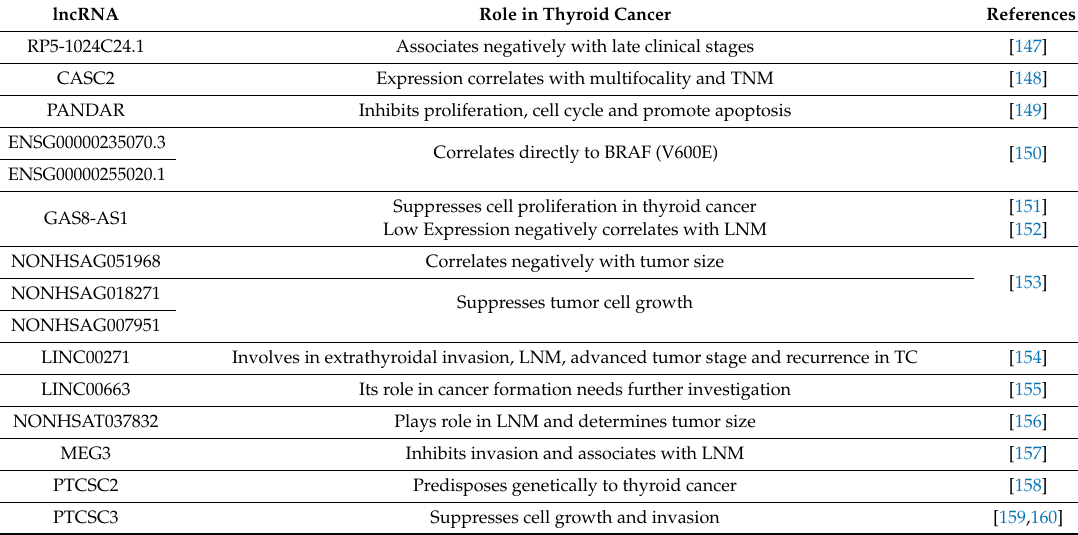
Table 4. LncRNAs associated with thyroid cancer